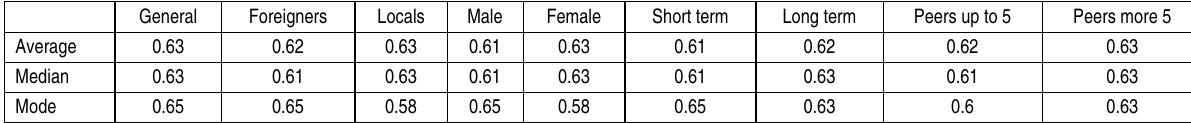
Table 2. Average, mean and mode CPM results of all groups in comparison